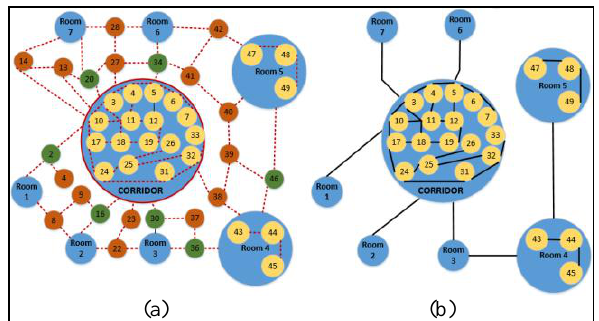
Figure 6. Topology graphs reconstructed for the second floor of the synthetic point cloud containing adjacency and containment relations (a), and connectivity and containment relations (b).